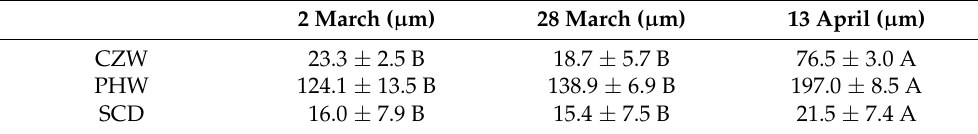
Table 1. Statistics on the Chinese fir cambium zone data. CZW: Cambium zone width; PHW: Phloem width; SCD: Sieve cell inside diameter.